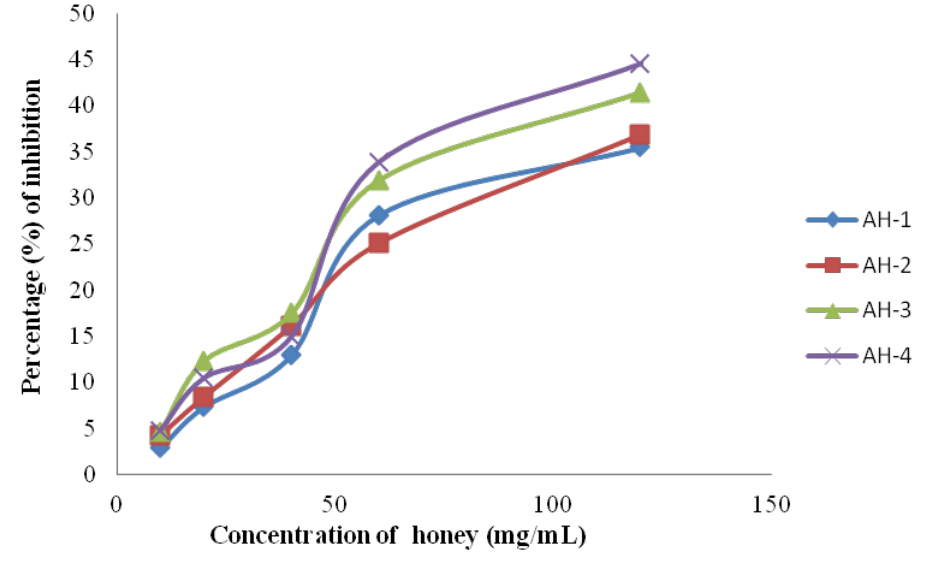
Figure 2. Percentage of inhibition of DPPH radical scavenging activity at different concentrations of Algerian